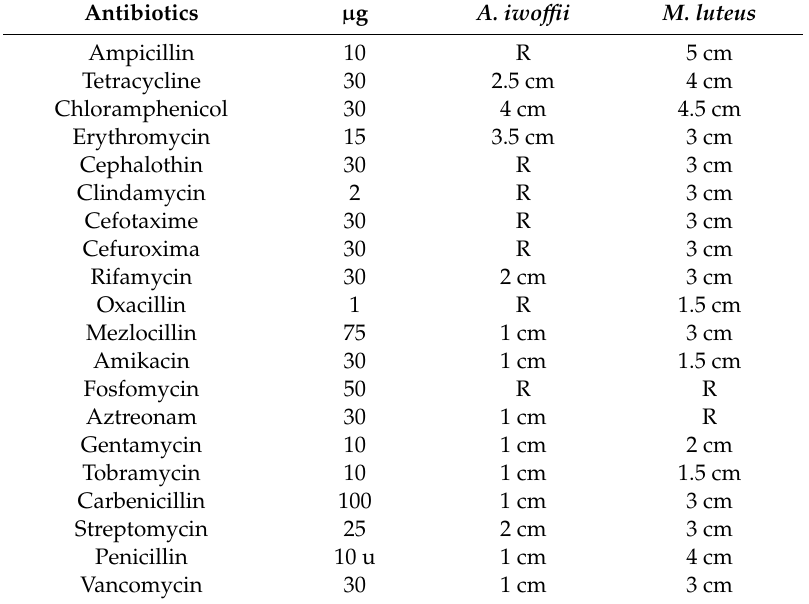
Table 6. Antibiotic resistance of isolated Micrococcus luteus and Acinetobacter iwo ffi i . The table shows resistances (R) and inhibition zones with relative measures in centimeters (from the center of the disc) for each tested molecule. R means that no inhibition zone was detected. Antibiotics µ g A. iwo ffi